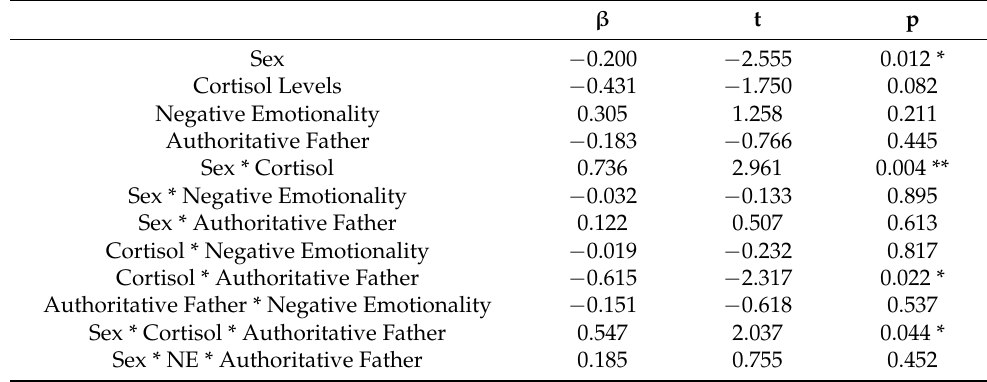
Table 3. Regression analysis for aggressive behavior including authoritative father and negative emotionality.